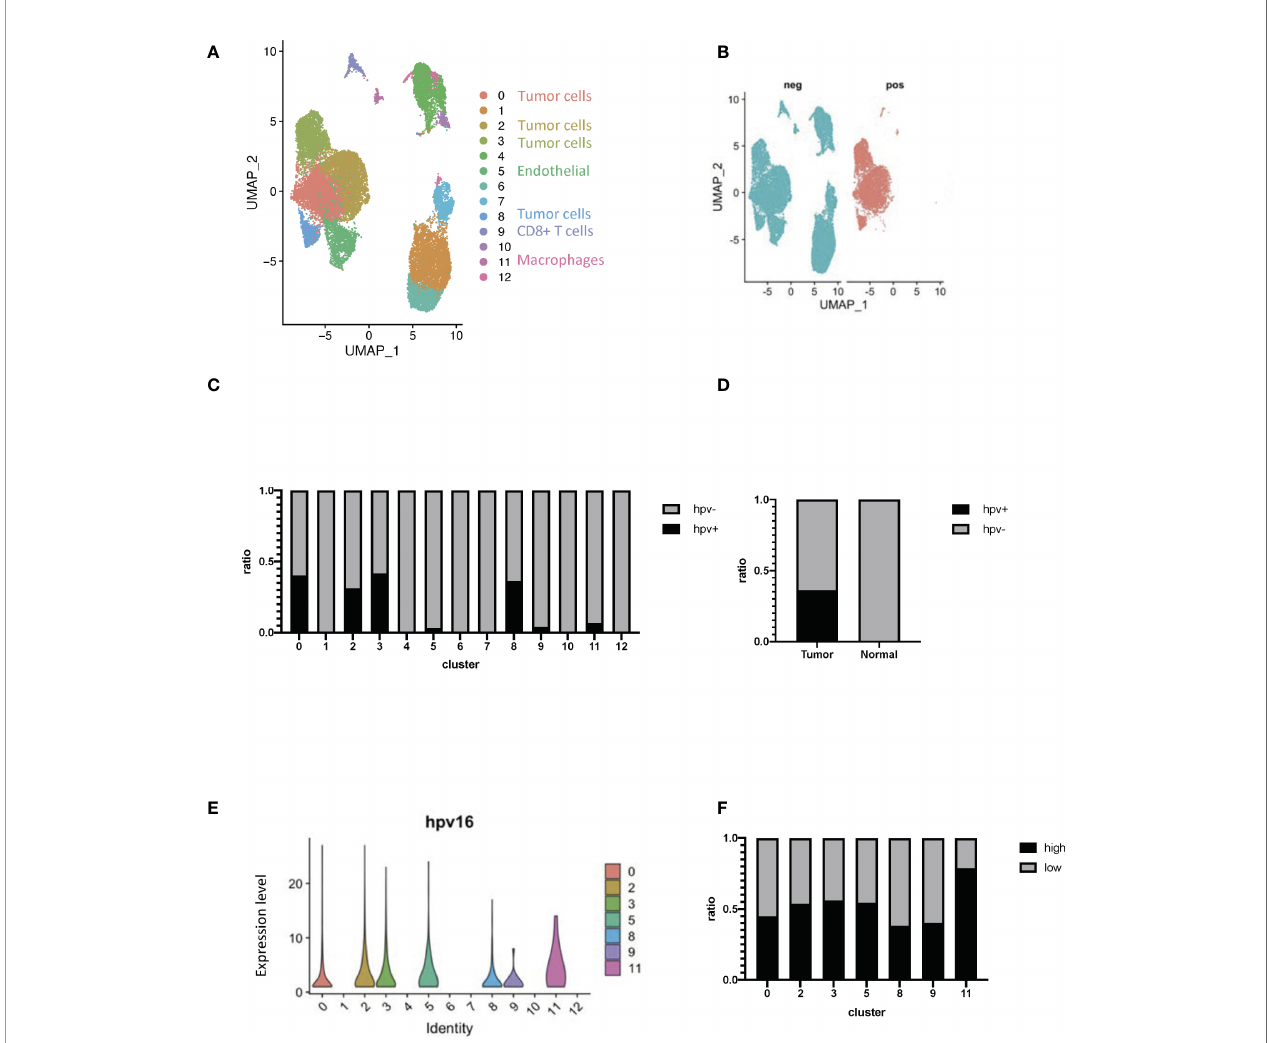
FIGURE 2 | Transcriptome pro fi ling of HPV + cells. (A) A UMAP diagram showing the cell clusters (B) UMAP diagrams showing HPV + and - cells. (C) The bar graph quanti fi es and compares the proportion of HPV + and - cells in the main cell types. (D) A bar graph to quantify and compare the proportions of HPV + and HPV - cells. (E) Violin plots indicating the expression of HPV in the main cell types. (F) The bar graph depicts the proportion of HPV high and low cells in the infected cell types. HPV high refers to the cells with hpv16 counts of more than